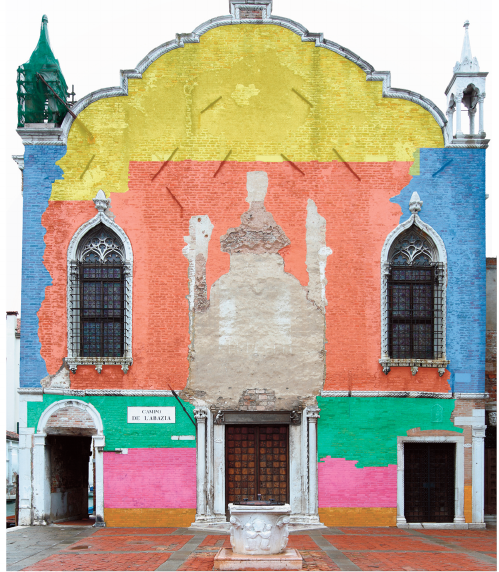
Figure 7: a rectified image with the detected